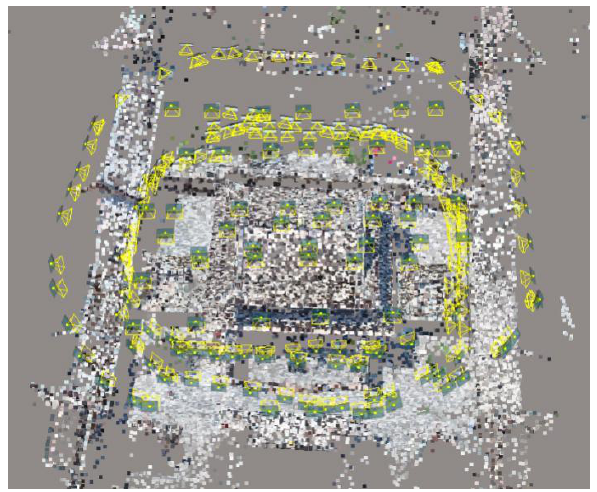
Figure 3 . The aerial route of the UAV collecting image